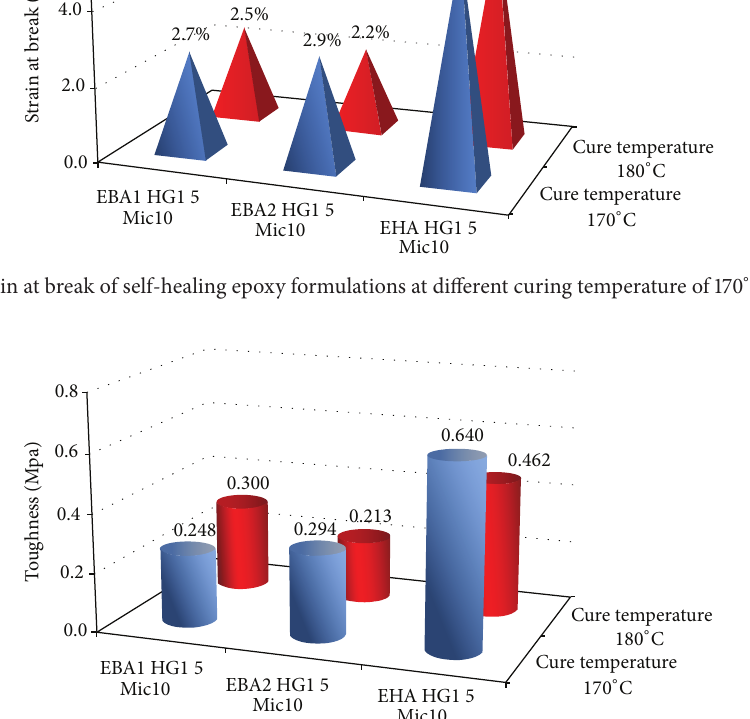
for all the samples; in particular EBA2 toughness value goes down with respect to the other samples.